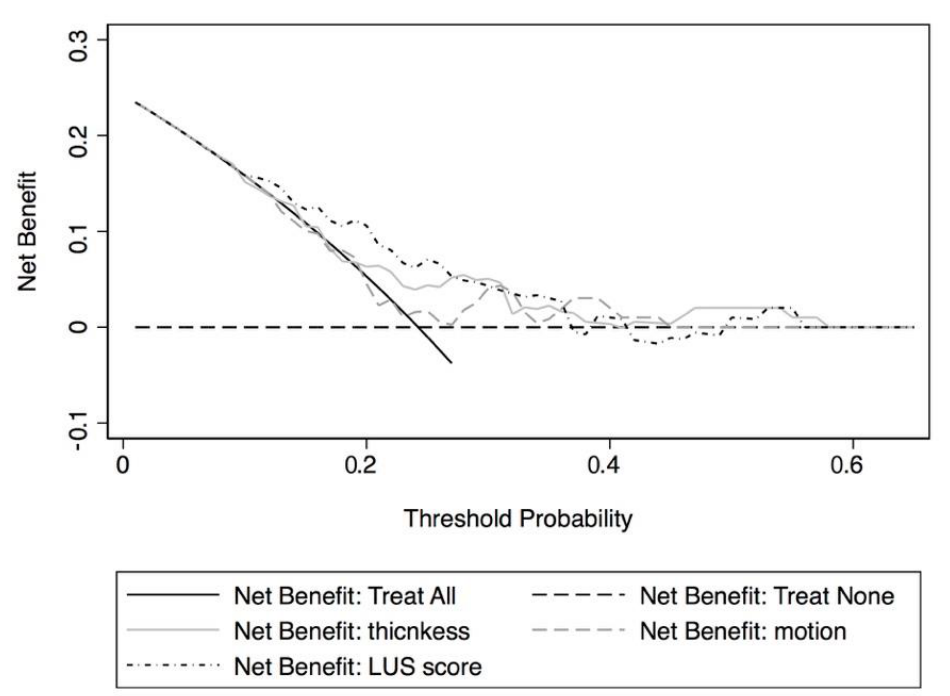
Figure 3. Decision curves for 30-day outcomes for diaphragmatic thickness, motion, and LUS score at ED evaluation.